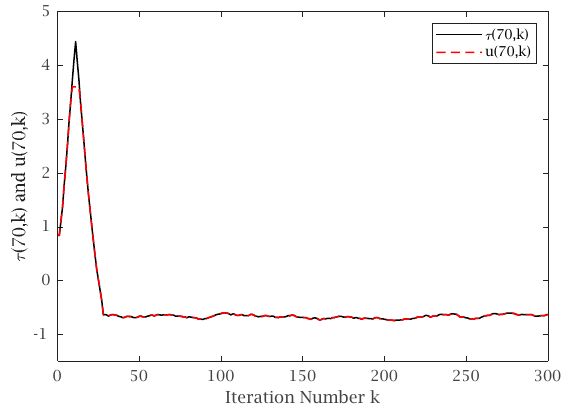
Figure 6. The tracking curves of iteration 100 and iteration 200, respectively.